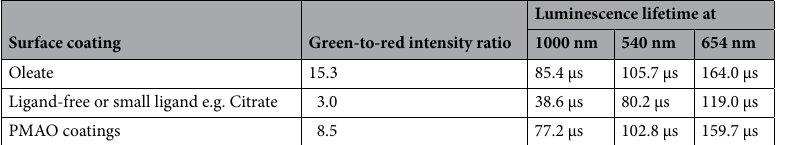
Table 2. Spectroscopically determined parameters for differently coated UCNPs. a Intensity-weighted